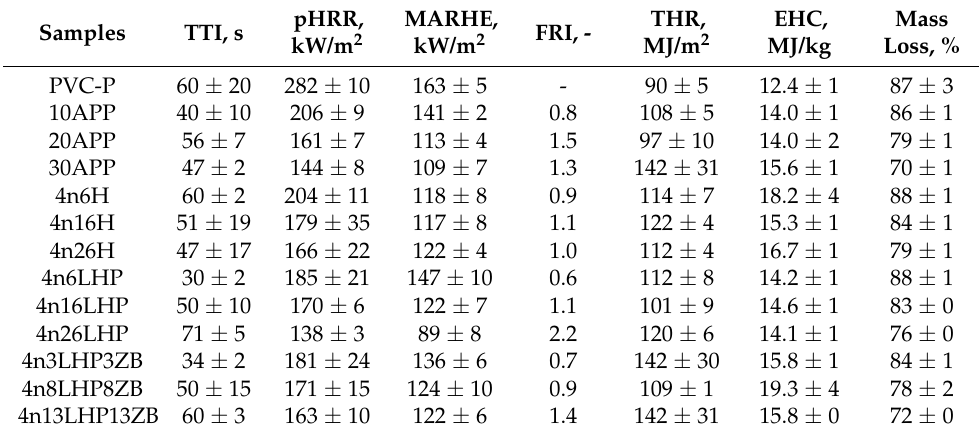
Table 4. Cone calorimeter results of PVC-P and PVC/FR.